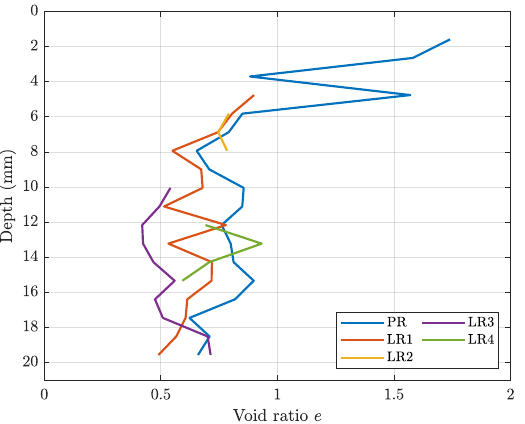
Figure 4. Void ratio profile for primary root (PR), lateral roots (LR) in coarse glass ballotini.